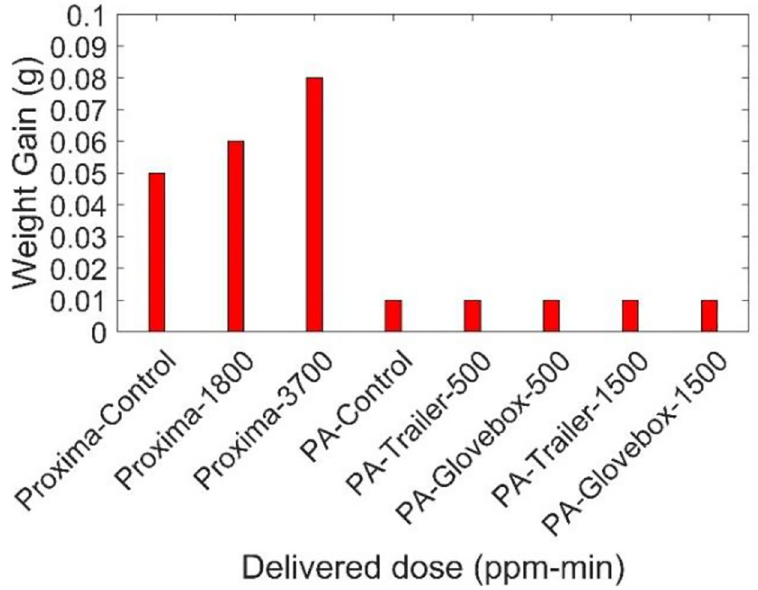
Fig 19. Impact pentration testing results of different Proxima and Prestige Ameritech gown samples.